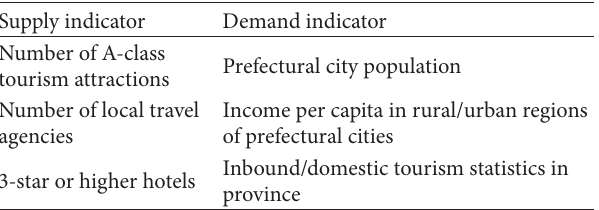
Table 1: Supply and demand system indicators. Supply